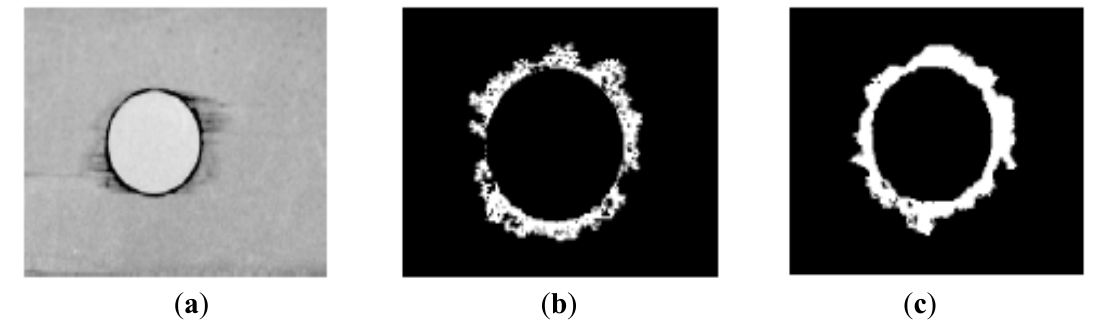
Figure 5. Damage evaluation: ( a ) radiography [26]; ( b ) ultrasonic C-Scan [28]; ( c ) computerized tomography